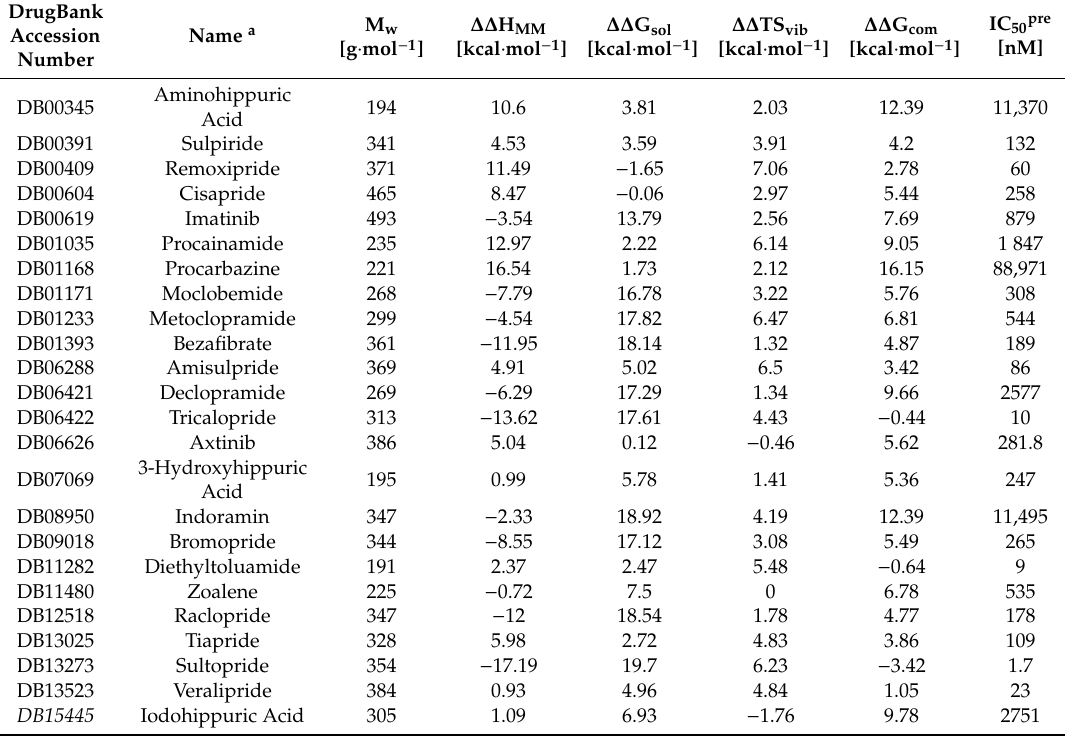
Figure 9. Mapping of the benzamide drugs currently used in clinical practice to the InhA inhibition pharmacophore. Feature legend: HYDA = Hydrophobic Aliphatic (blue), HYD = Hydrophobic (cyan), Ar = Ring aromatic (orange), HBA = Hydrogen bond Acceptor (green). Only the top five predicted IC 50pre are displayed. Table 8. GFE, its components, and predicted InhA inhibitory potencies of 24 approved drugs which contain benzamide scaffold in their molecular structure (for 2D representation see Table 9).